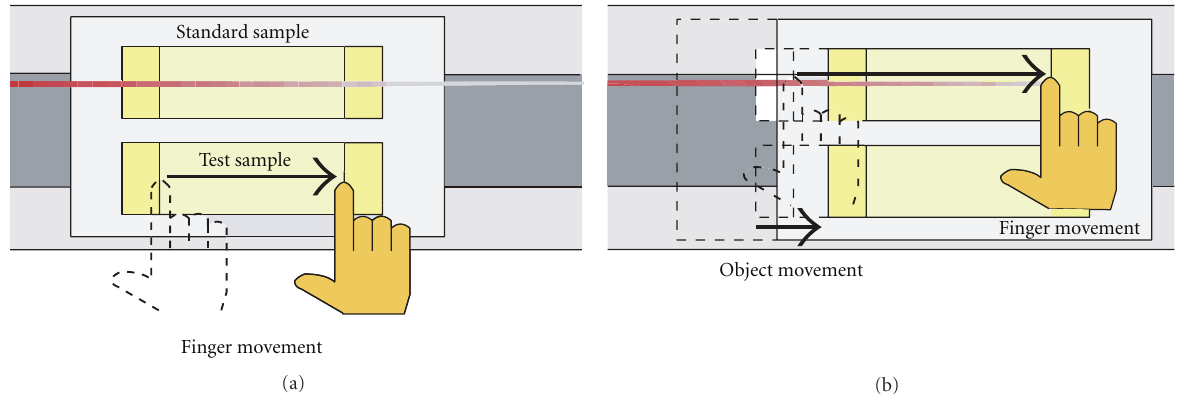
Figure 5: Experimental procedures. (a) The participant traced the test length sample while the linear slider was static. (b) The participant traced the standard length sample while the linear slider was moved at a relative velocity rate α